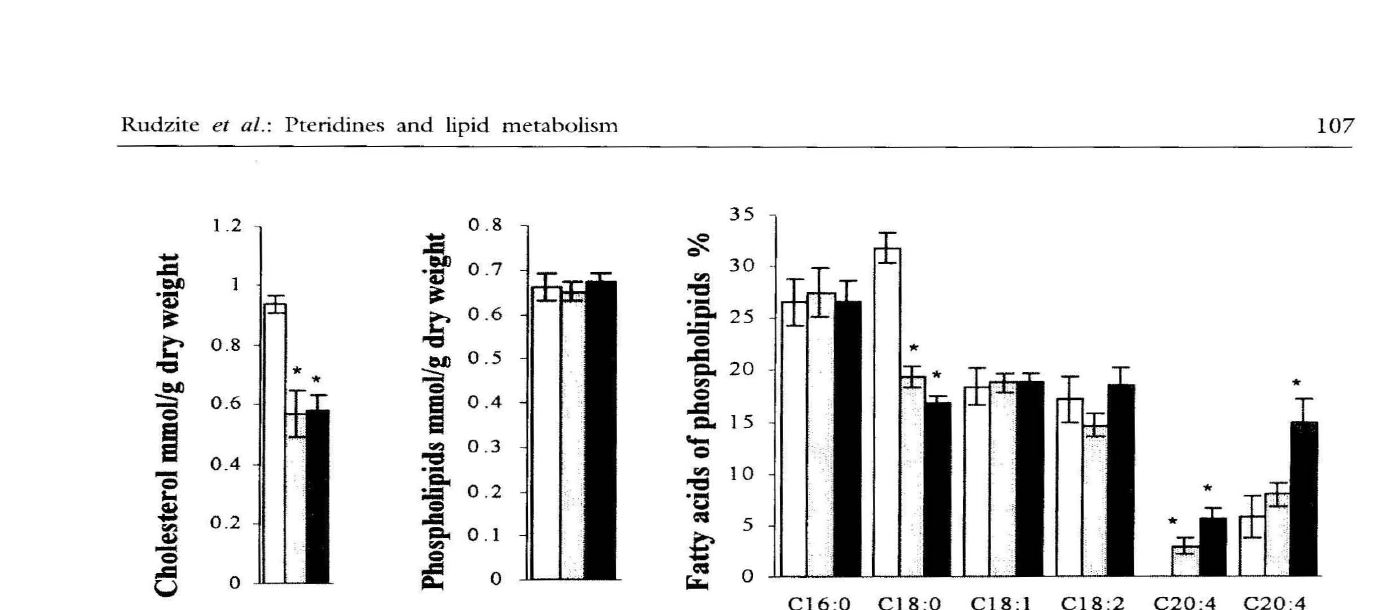
Figure 5. Concentrations (mean ± S.D.) of cholesterol and phospholipids, as well as fatty acid content (in percent: mean±S.D .) in controls (open bars) and in samples with 5 pmoljg wet weight 5,6,7,8-tetrahydrobiopterin (dotted bars) and 30 pmoljg wet weight 5,6,7,8-tetrahydrobiopterin (hatched bars). Samples of rat liver tissue homogenates were used to test for phospholipid biosynthesis in vitro. Incubation medium: Krebs-Ringer-phosphate butte r, con taining 0.3% albumin (pH=7.4 ), fatty acid mixture and glycerol. Samples were incubated twice for 4 hat 37"C . *The changes are statistically significant (p<O.OO 1).